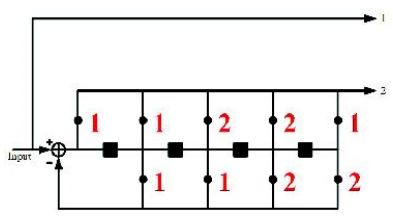
Figure 5. 3-Ary, constraint length = 5, η = Figure 5. 3-ary, constraint length = 5, Figure 5. 3-ary, constraint length = 5,